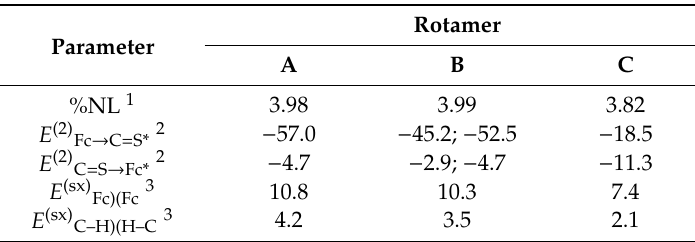
Table 6. Selected NBO parameters for the rotamers of an isolated Fc 2 CS molecule. All energies are given in kcal mol − 1